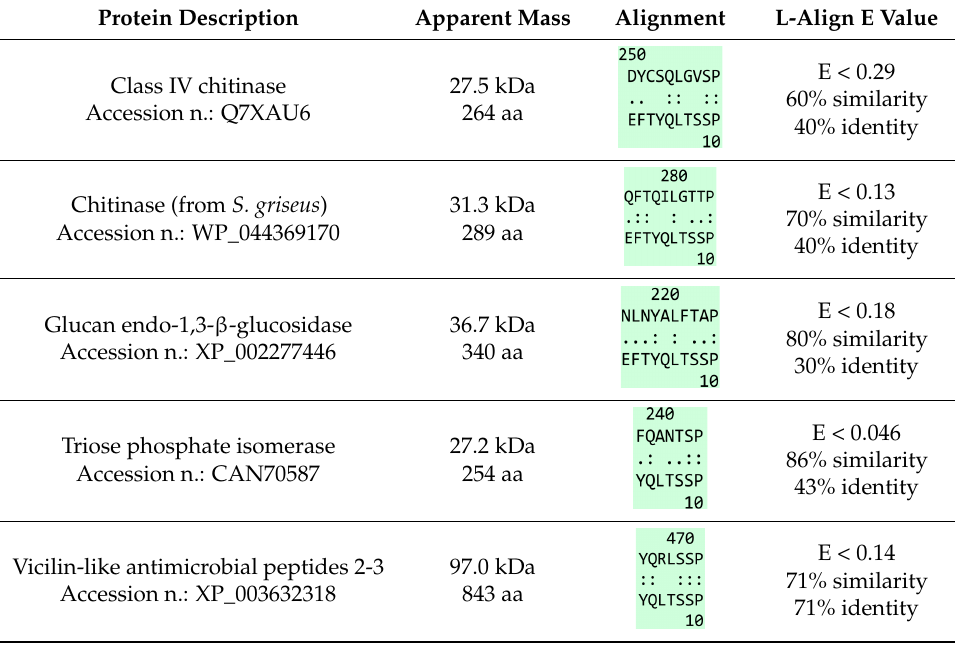
Table 2. Sequence alignment of proteins detected as reacting with the Ab raised against the peptide 235–246 of bilitranslocase. The rat enzyme is reported at the bottom of the each sequence alignment, while the target one is shown at the top.